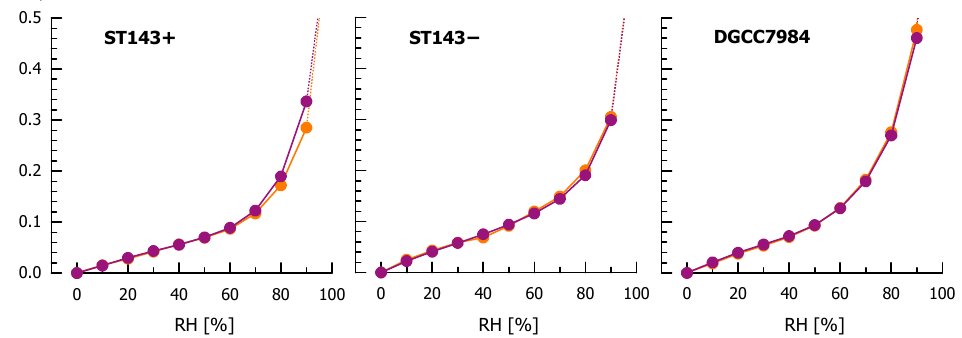
Figure 6. Equilibrium moisture load X eq [g H 2 O / g dry matter] of S. thermophilus ST143 + , ST143 − and DGCC7984 cells at di ff erent relative humidity (RH) levels, determined by dynamic vapor sorption analysis. Violet: untreated cells; orange: ultrasonicated cells.